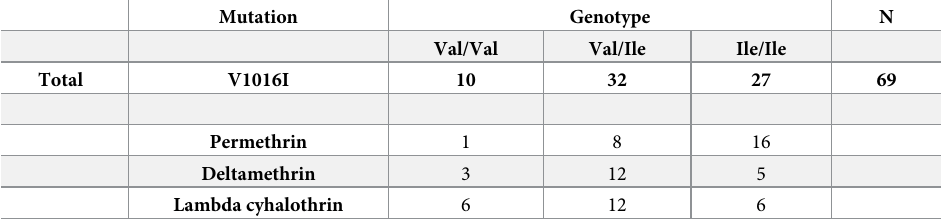
Table 2. Kdr Genotype Frequencies in Live Field Adult F0 Ae. aegypti Collected from St. Catherine,